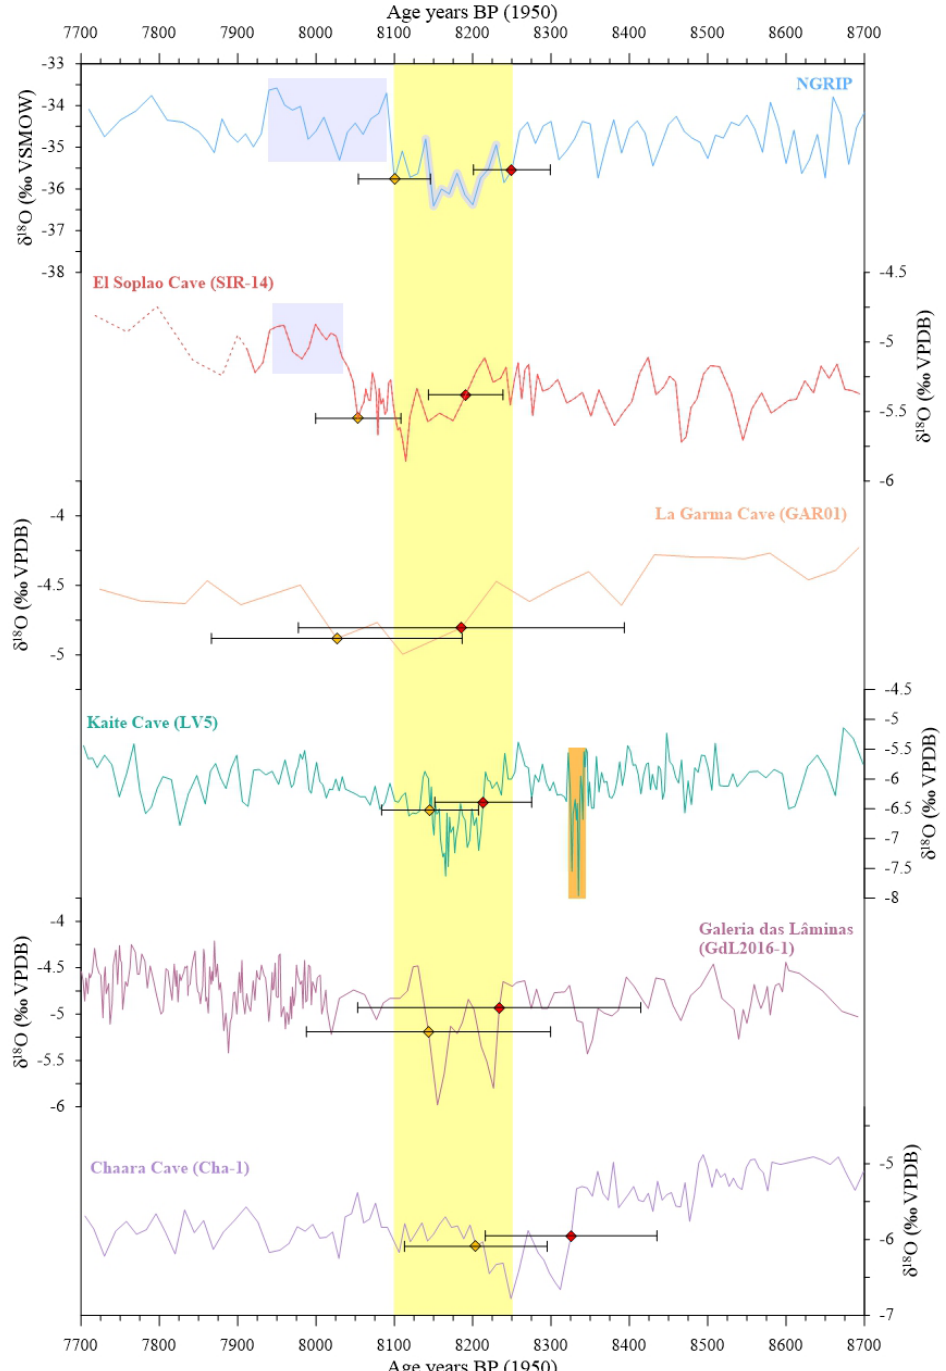
Figure 7. Comparison of δ 18 O variability from selected archives across the 8.2ka event. From top: NGRIP, SIR-14, GAR01, LV5, GdL2016- 1 and Cha-1 (for references, see Fig. 5). The duration of the 8.2ka event (as inferred from the NGRIP record) is highlighted by yellow shading. The double trough (central part of the event; Thomas et al., 2007) is marked with a thick grey line in the NGRIP profile. Orange shading indicates the “precursor event” identified in the Kaite Cave record. Blue shading indicates the interval where δ 18 O overshoots after the event in the NGRIP and SIR-14